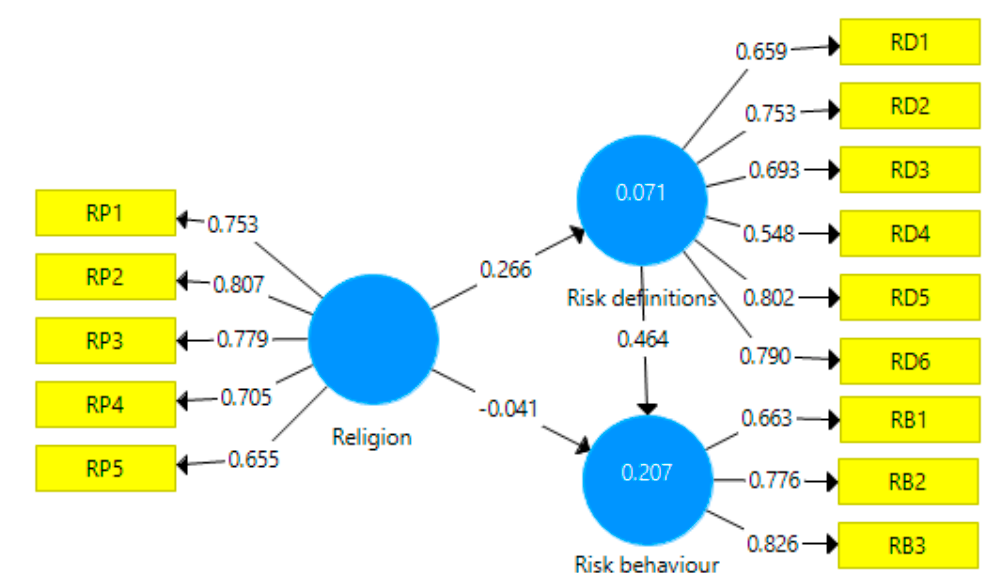
Figure 2. Model One Structural Path Graph (Source: Authors’ Compilation).